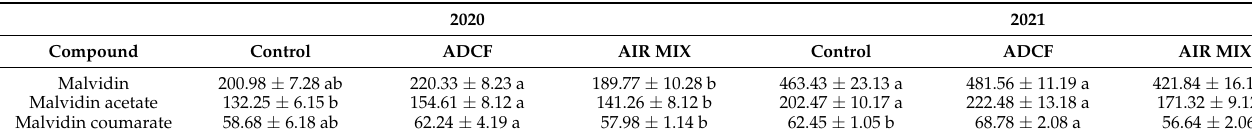
different data (Tukey, p ≤ 0.05).